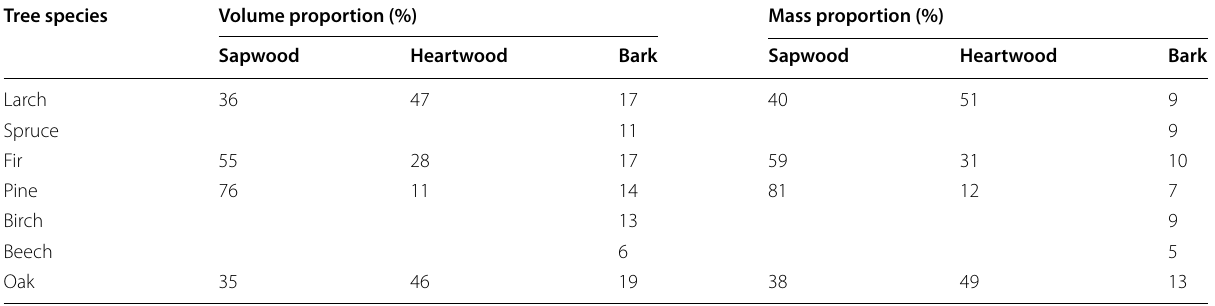
Table 9 Volume (including bark VOID) and mass proportions (%) per compartment for sapwood, heartwood and bark for seven tree species. Note that sapwood and heartwood are not distinguished for Norway spruce, birch and beech